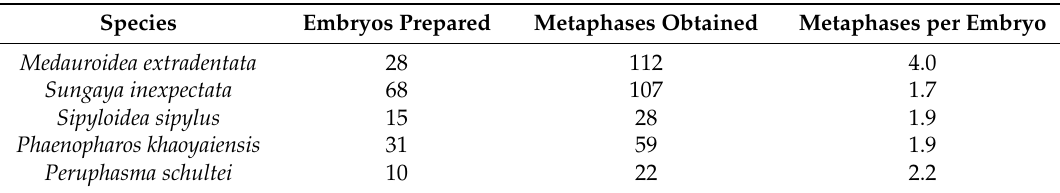
Table 1. Number of metaphase plates per analyzed